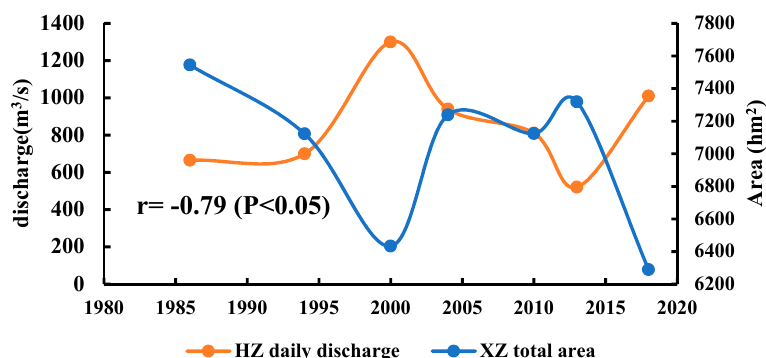
Figure 8. Changes in daily discharge at Huangzhuang station (HZ) and total channel bar area in XZ reach.